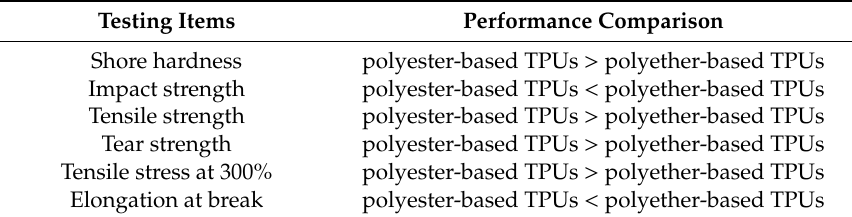
Table 13. Performance comparison of polyester-based and polyether-based